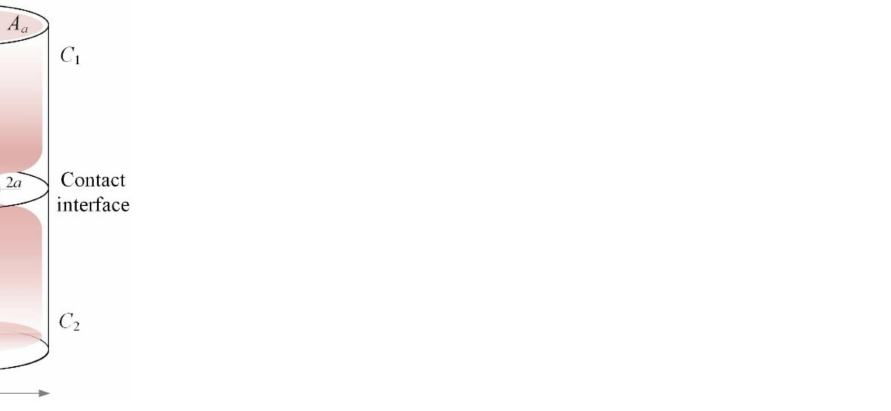
Figure 3. Holm contact resistance model: cylinders in contact showing the apparent area of contact ( Aa ), the real area of contact ( Ac ), and the radius R with a circular constriction of the current lines of radius a